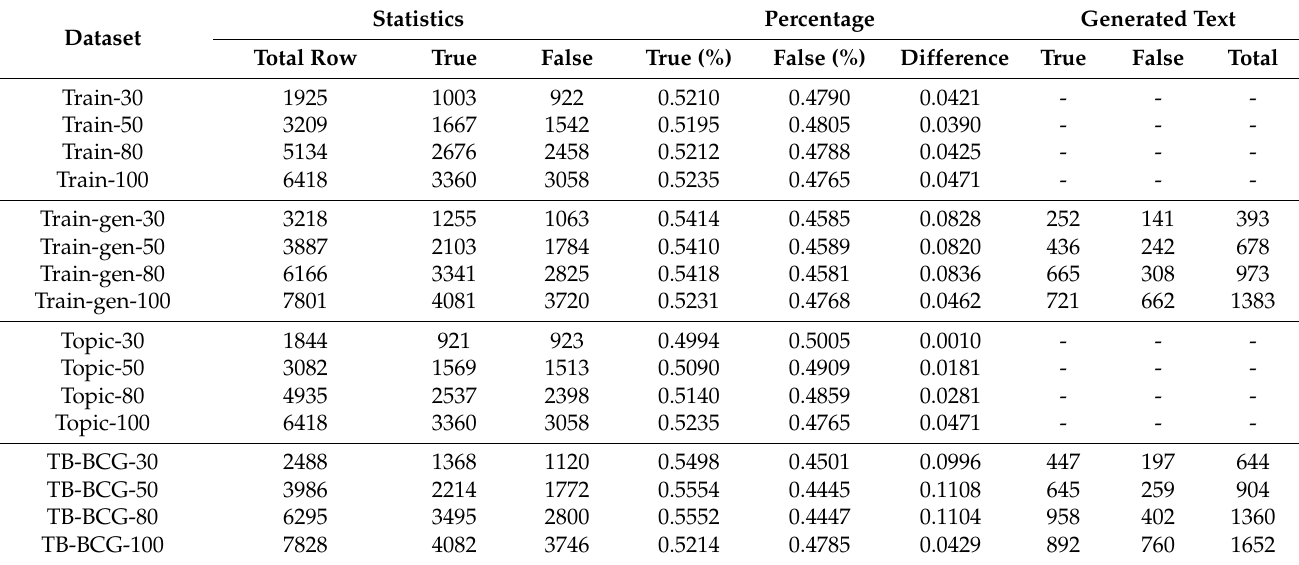
Table 6. Statistics, Percentage, and Counterfeit-Generated Text in